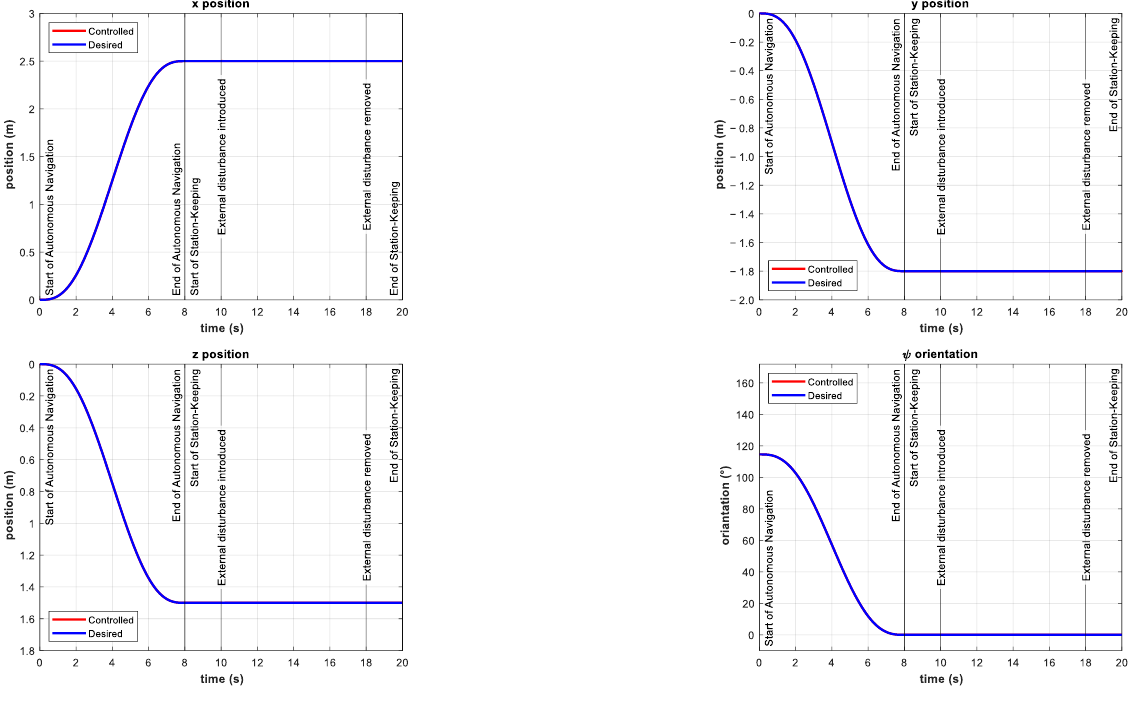
Figure 9. Simulation results for finite-time trajectory tracking and station-keeping in the 𝑥 , 𝑦 , 𝑧 positions and 𝜓 orientation. External disturbances were introduced in the interval 10 s ≤ 𝑡 ≤ 18 s as ocean currents (𝜈 𝑜𝑐 ).